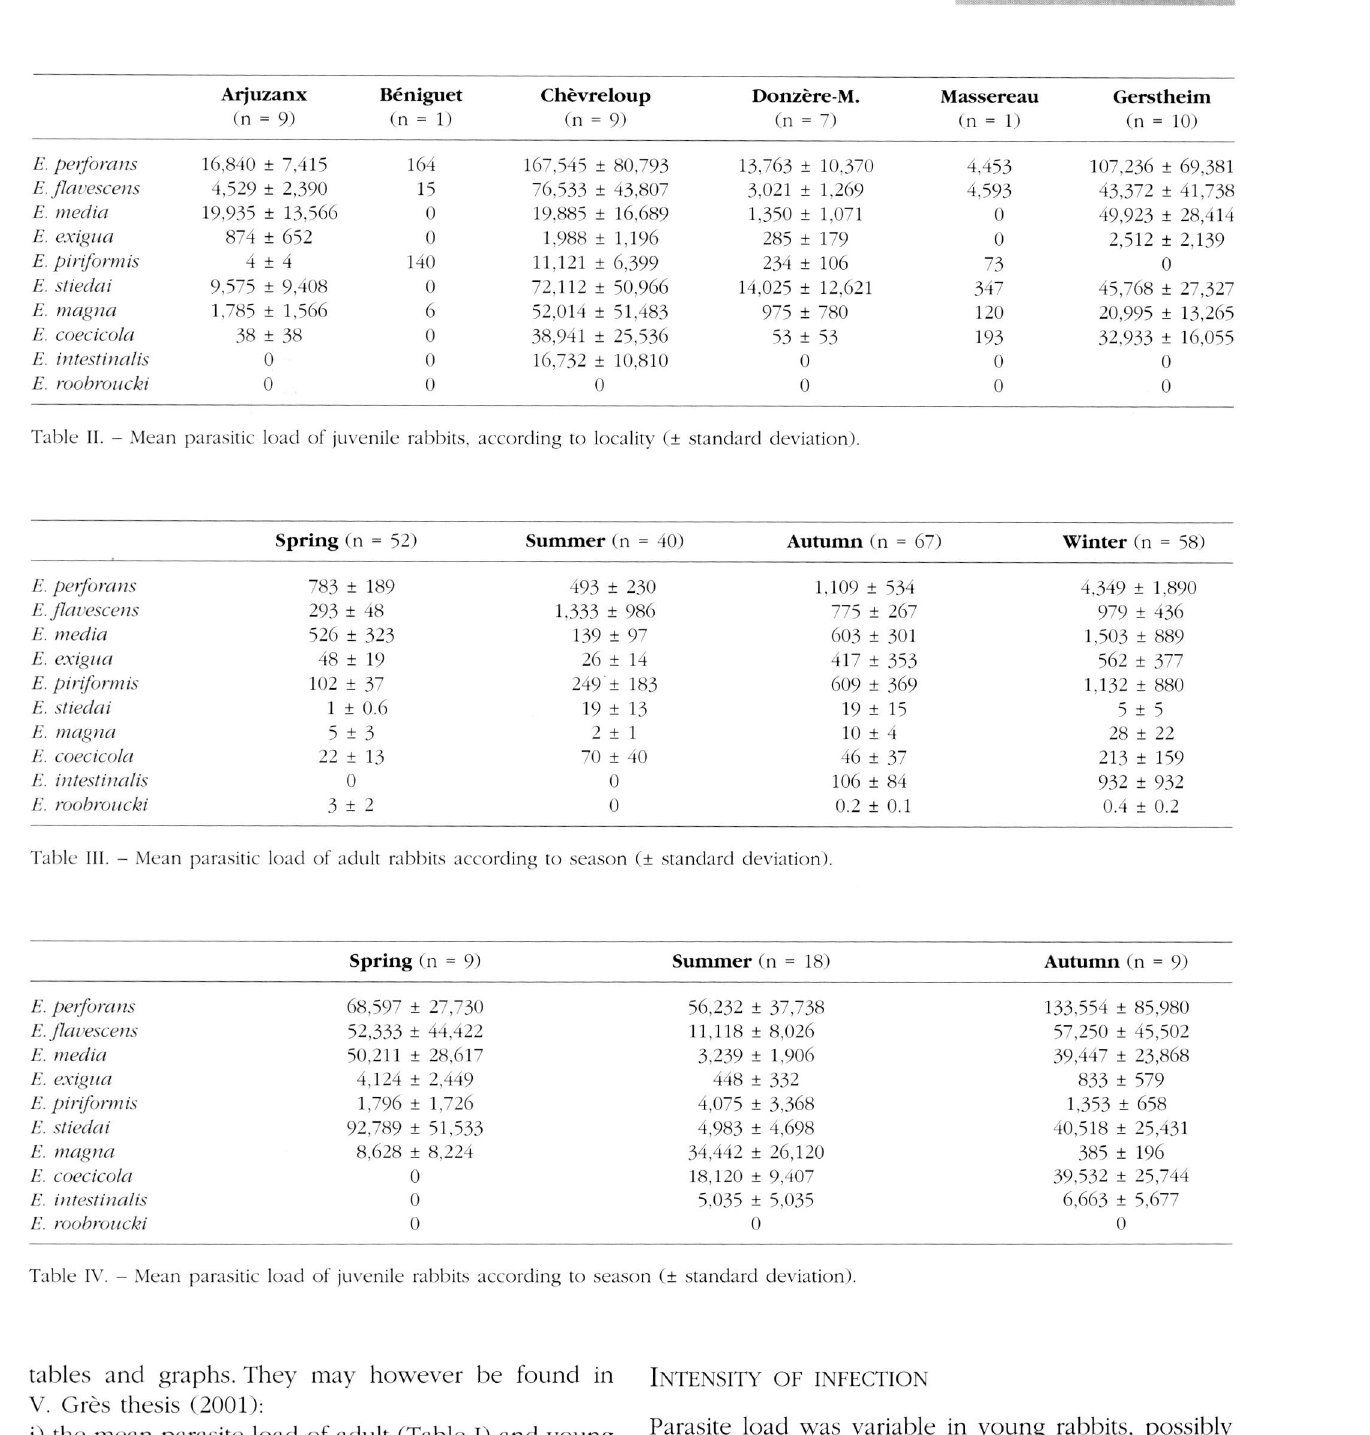
Table IV. - Mean parasitic load of juvenile rabbits according to season (± standard